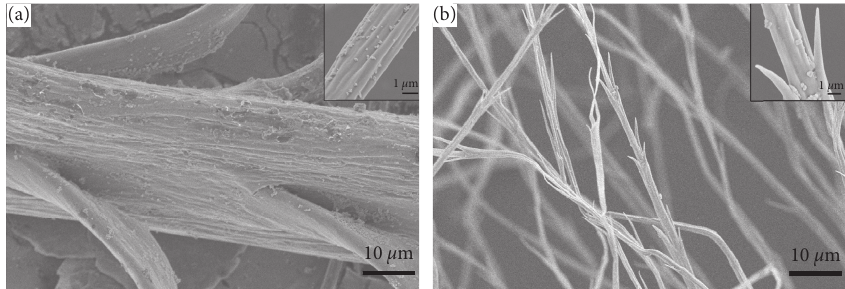
Figure 6: SEM pictures of down fiber. (a) Before washing. (b) After washing six times.